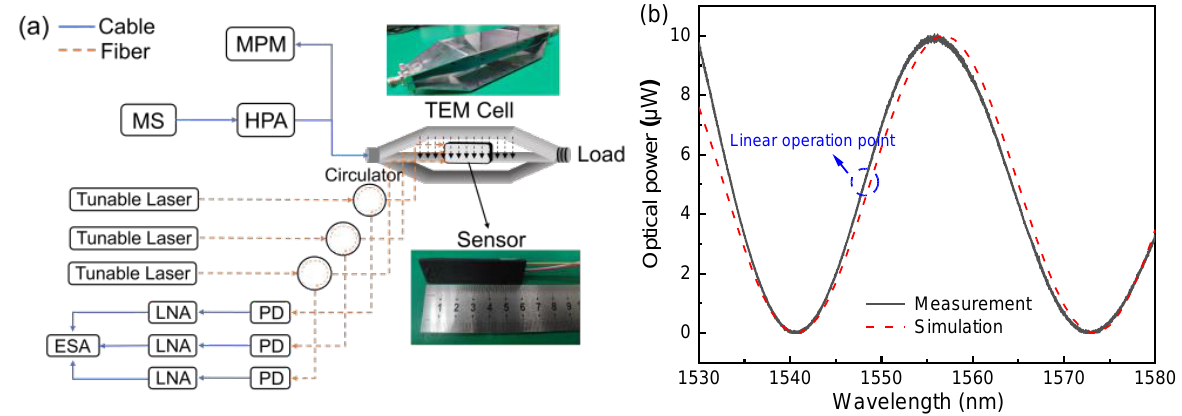
Figure 5. ( a ) Photograph of the packaged 3D sensor and the electric field measurement system; ( b ) measurement and simulation transmission optical spectrums of the sensor chip. ESA: electrical spectrum analyzer; PD: photodetector; HPA: high-power amplifier; MS: microwave source; LNA: low-noise amplifier; MPM: microwave power meter.